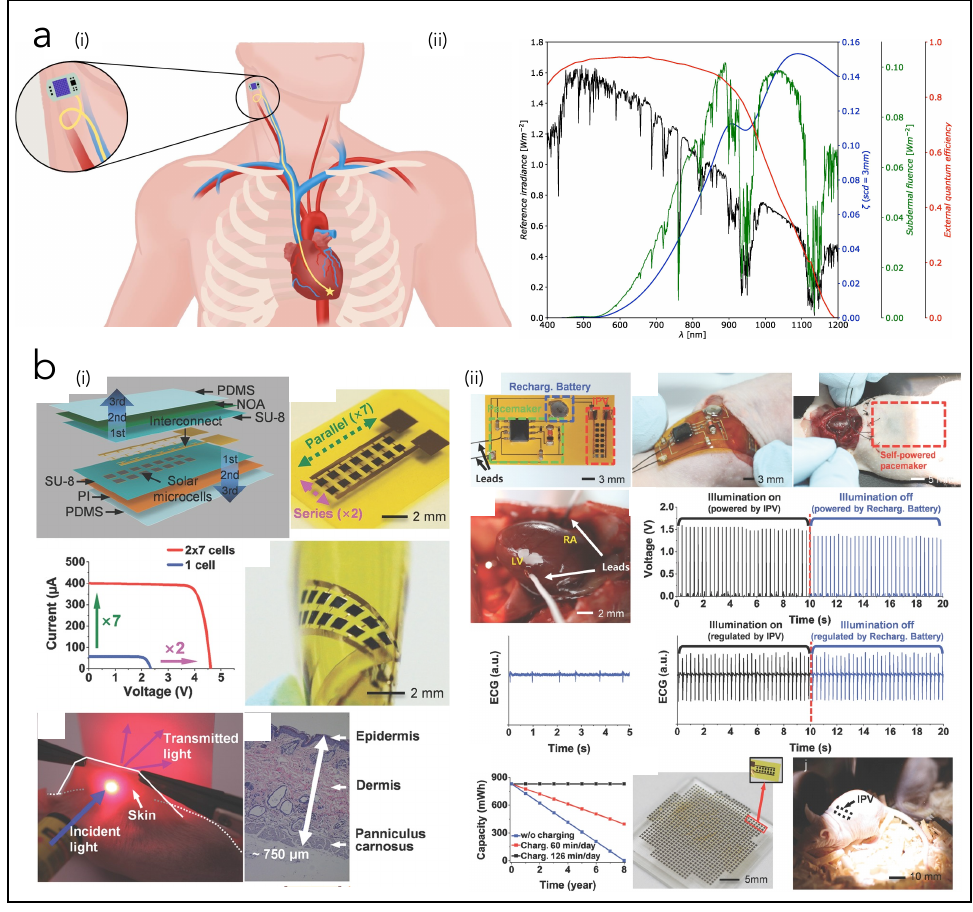
Figure 5. SCs for heart energy harvesting. ( a ) Illustration of a solar cardiac pacemaker implanted subdermally (i). Simulated fraction of light absorbed by a subdermal solar cell (ii). Reprinted with permission from reference [173], 2020 Copyright Elsevier. ( b ) Subdermal implantable photovoltaic device based on SU-8, PDMS, NOA, and solar microcells (i) for powering a subdermally-implanted flexible cardiac pacemaker in a live mouse (ii); the leads from the implanted self-powered pacemaker contact the right atrium (RA) and left ventricle (LV) of the heart. Adapted with permission from reference [171], 2016 Copyright